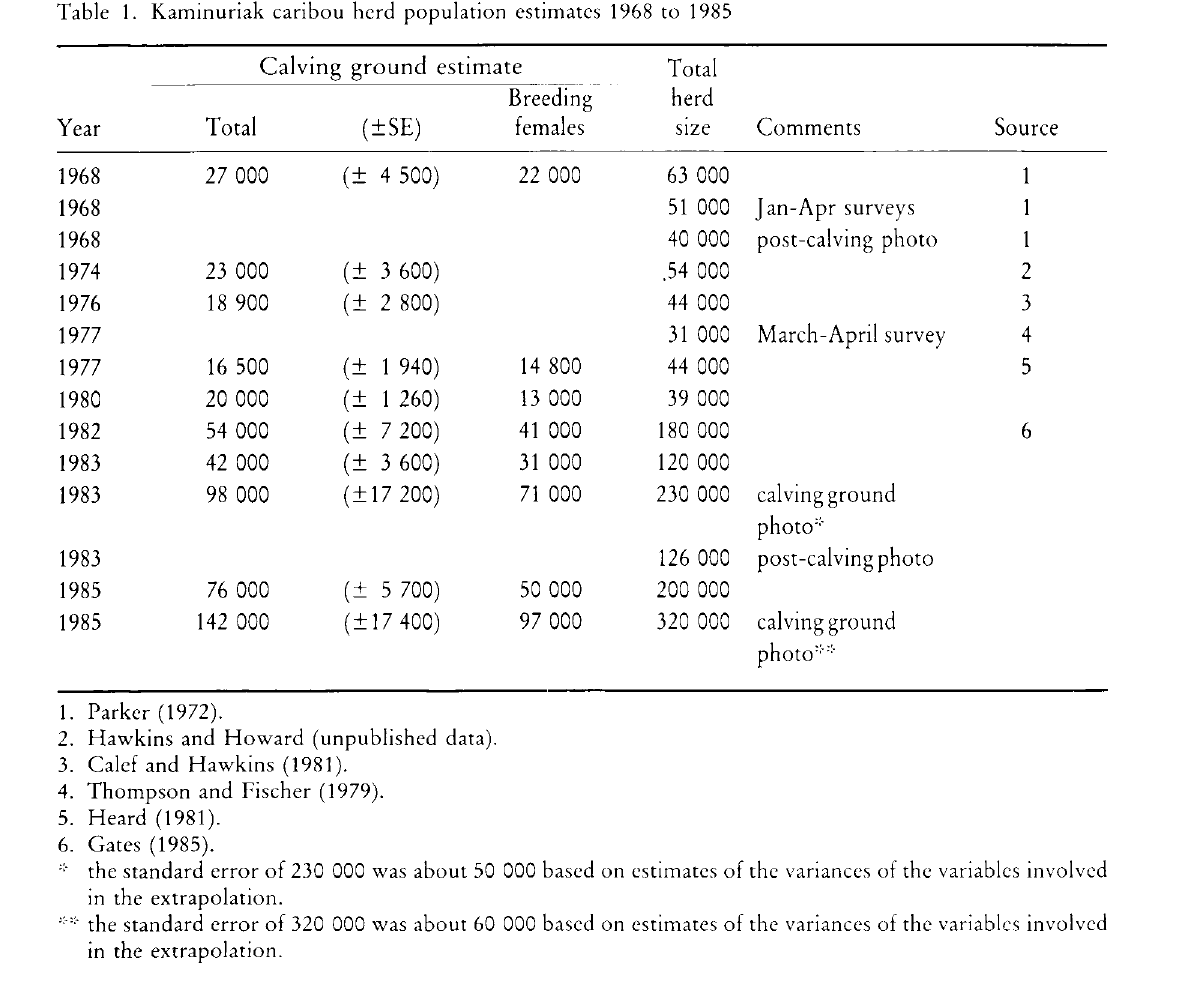
Table 1. Kaminuriak caribou herd population estimates 1968 to